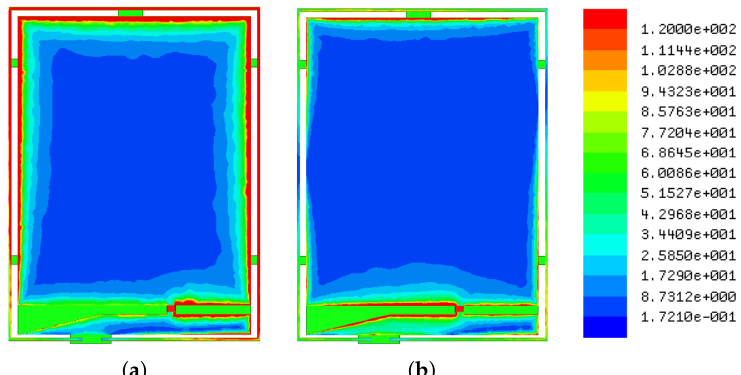
Figure 6. Simulated surface current distribution of the antenna at ( a ) low-frequency band and at ( b ) high-frequency band.